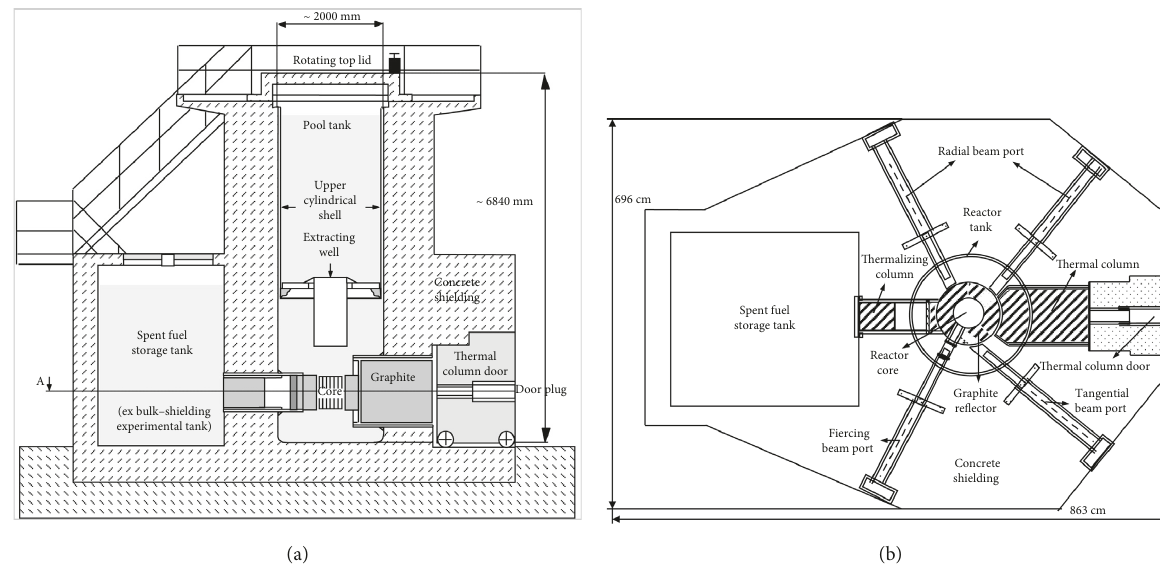
Figure 1: Vertical (a) and horizontal (b) section views of the DNRR structure